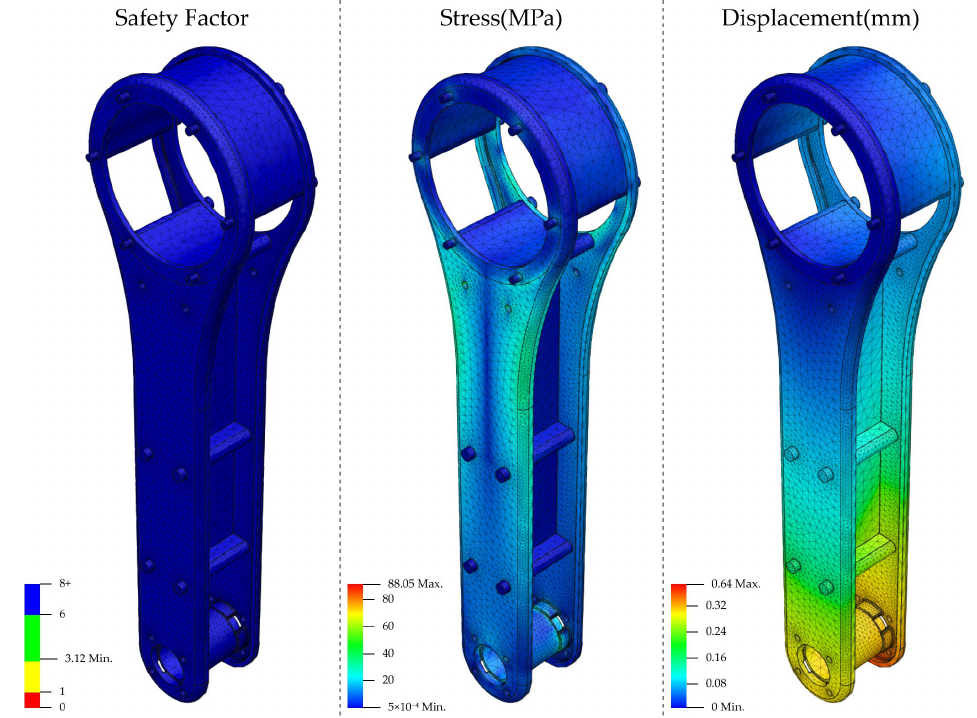
Figure 14. Analysis of condition 1 for the upper link. From left to right are the safety factor, stress, and displacement.